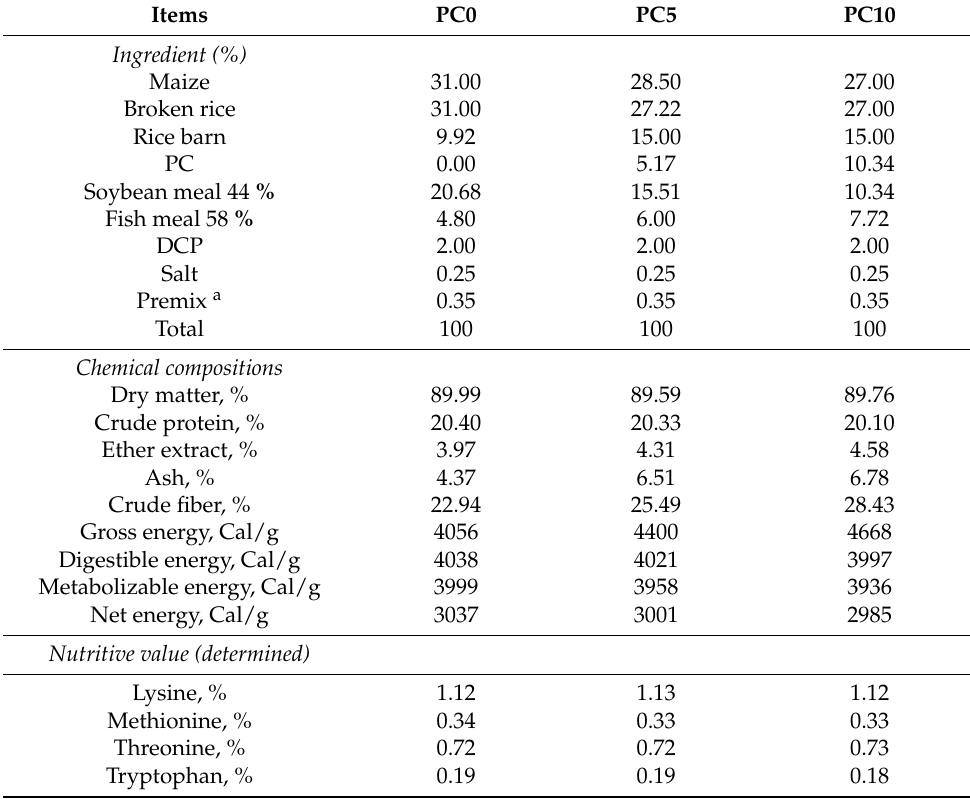
Table 1. The diet formulation and nutritional values of perilla cake in growing pig